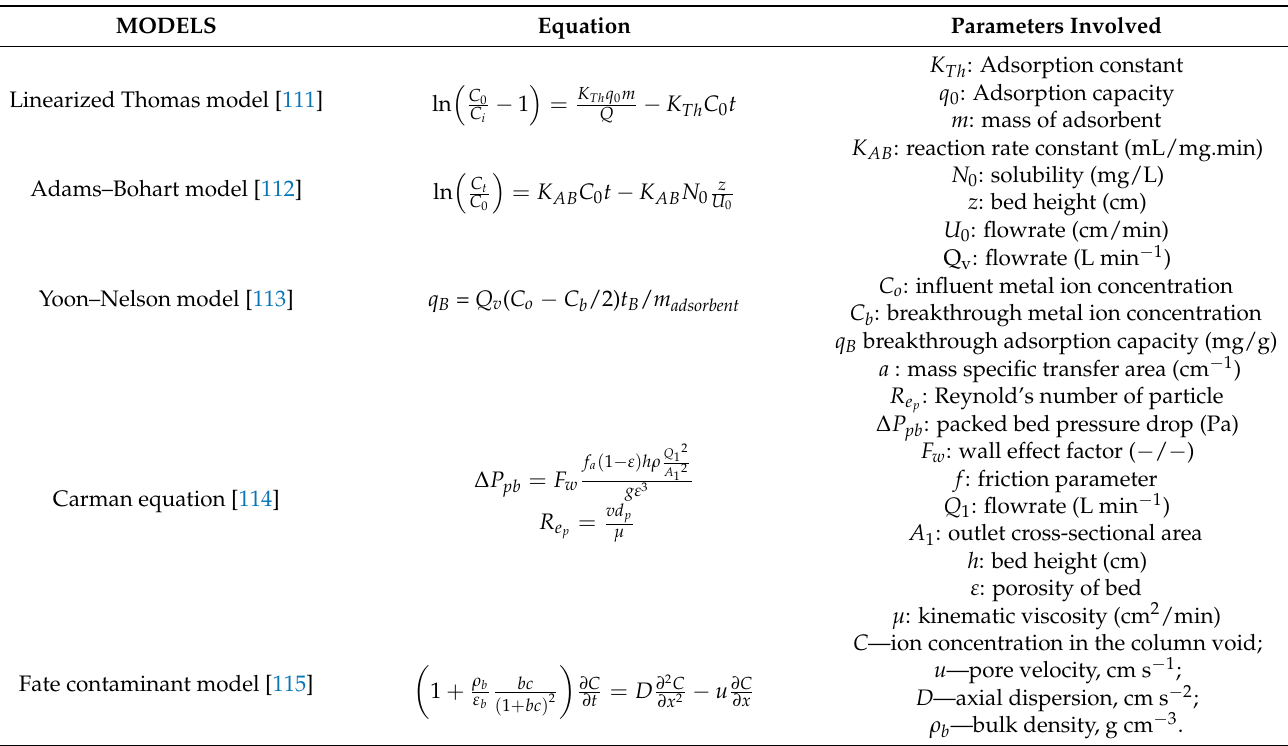
Figure 2. ( A ) A schematic of the adsorption of metal in a fixed-bed column. Experimental equilibrium isotherms fitted according to the Langmuir model for monocomponent adsorption in a fixed-bed column of ions Cu(II) ( B ), Ni(II) ( C ) and Zn(II) ( D ). Experimental conditions: initial pH of 4.0, average particle diameter of 0.61 mm, flow of 3 mLmin -1 bed length of 12 cm, 2 g of biomass, bed porosity of 0.28 and temperature of 25 ◦ C. ( E – G ) Experimental and modeled breakthrough curves for monocomponent adsorption in the fixed column of the Cu ion with initial concentrations of 1, 2 and 3 mmol L − 1 . Experimental conditions: initial pH of 4.0, average particle diameter of 0.61 mm, flow of 3 mLmin − 1 , bed length of 12 cm, 2 g of biomass, bed porosity of 0.28 and temperature of 25 ◦ C, adapted with permission from Ref. [110]. 2017, Elsevier. Table 5. A brief summary of the various models applicable to correlation of dynamic column biosorption